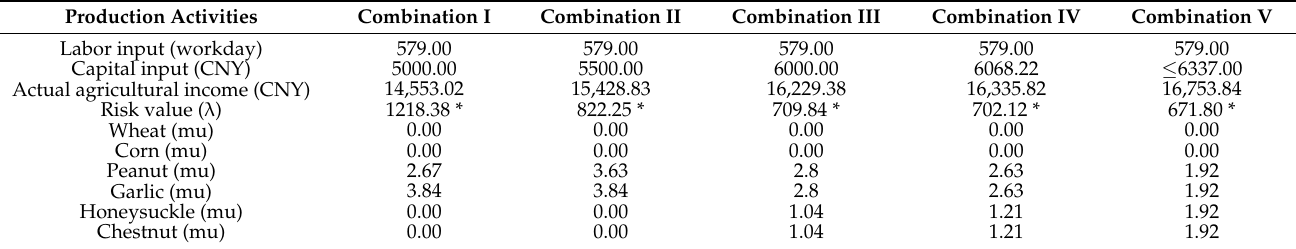
Table 6. Optimization of capital input for FTPH .